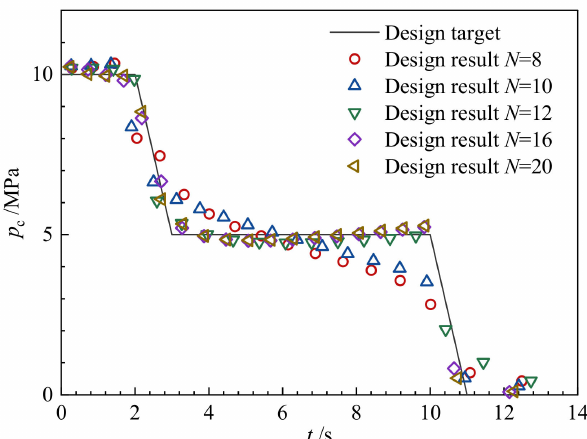
Figure 30. Reverse design results with different N .